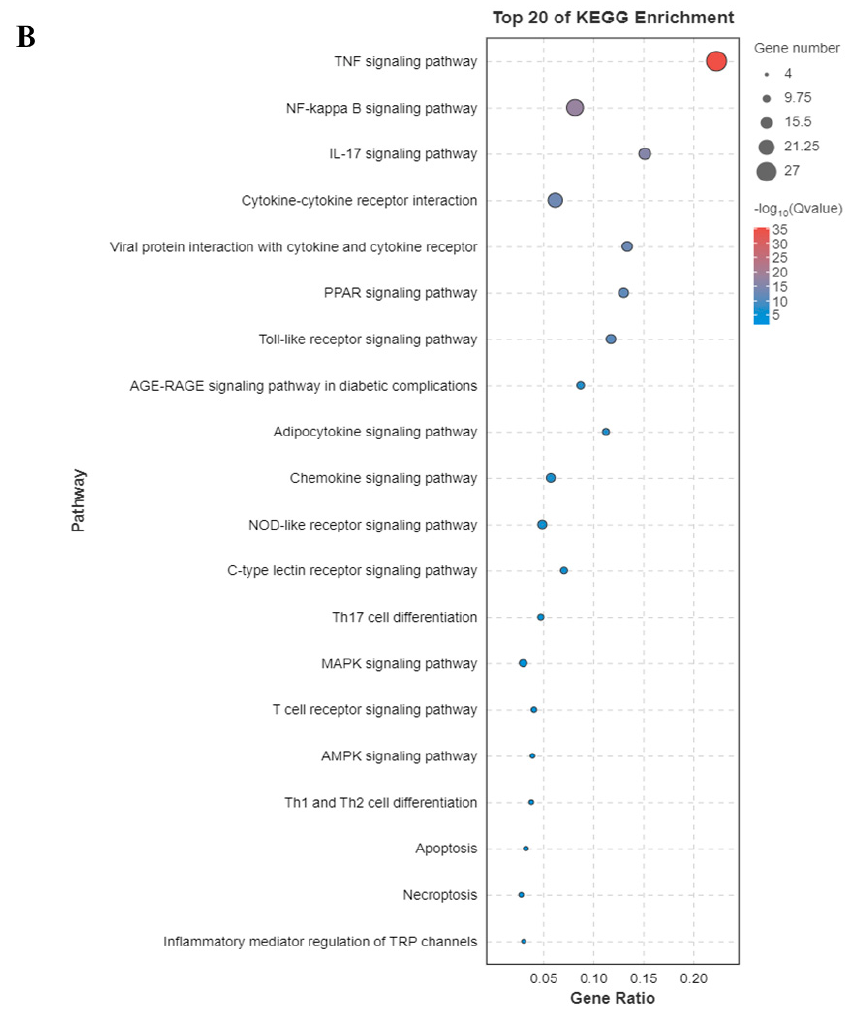
Figure 3. Pathway analysis of primary IECs in the co-culture system. ( A ) Top 20 GO annotations were enriched from 52 DEGs associated with inflammation. ( B ) Top 20 KEGG pathways were enriched from 52 DEGs associated with inflammation. Apo-LF represents individual treatment with 10 g/L apo-LF, LPS represents individual treatment with 1 mg/L LPS and apo-LF + LPS represents combined treatment with of 10 g/L apo-LF and 1 mg/L LPS.